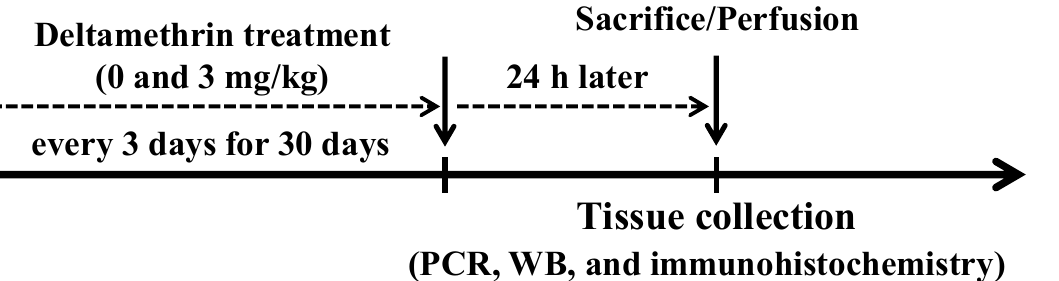
Figure 1. Mice were given 0 (corn oil) or 3 mg/kg of deltamethrin by oral gavage every three days for thirty (30) days. Twenty-four hours after the last dose, one set of animals ( n = 5/group) were sacrificed and hippocampi were collected for gene and protein analysis, and another set of animals (n = 5/group) were perfused for immunohistochemical study.